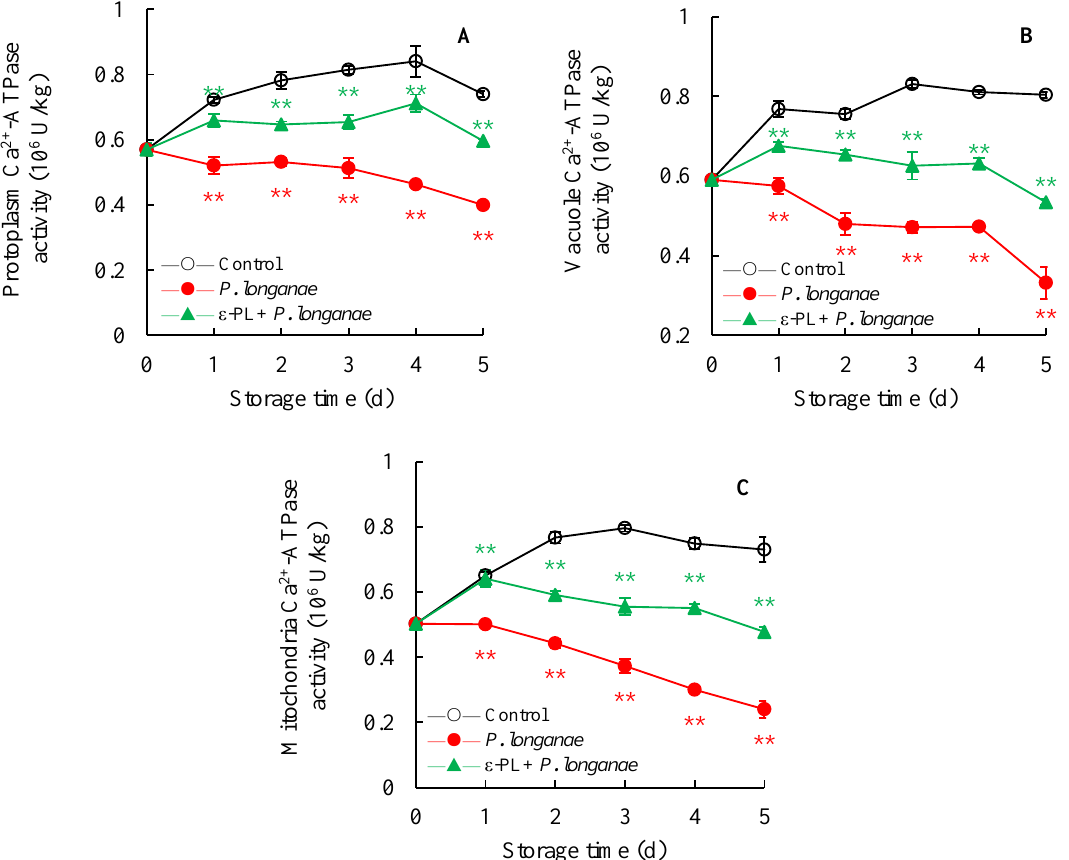
Figure 3. Effects of ε -PL treatment on activities of Ca 2+ -ATPase in membranes of protoplasm ( A ), vacuole ( B ), and mitochondria ( C ) in pericarp of P. longanae -inoculated longans. Value presented in figure equals mean ± standard error of triplicate analyses, vertical bars express the standard error of mean ( n = 3). The mark ** represents the significant difference ( p < 0.05 or p < 0.01) between the P. longanae -inoculated longans and the control longans on each storage day. The mark ** represents the significant difference ( p < 0.05 or p < 0.01) between the ε -PL-treated P. longanae -inoculated longans and the P. longanae -inoculated longans on each storage day. ○ , Control; ● , P. longanae ; ▲ , ε -PL + P. longanae .